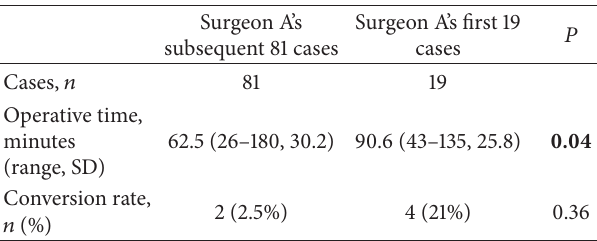
Figure 7: Operating time of cases assisted by assistants with and without CLC